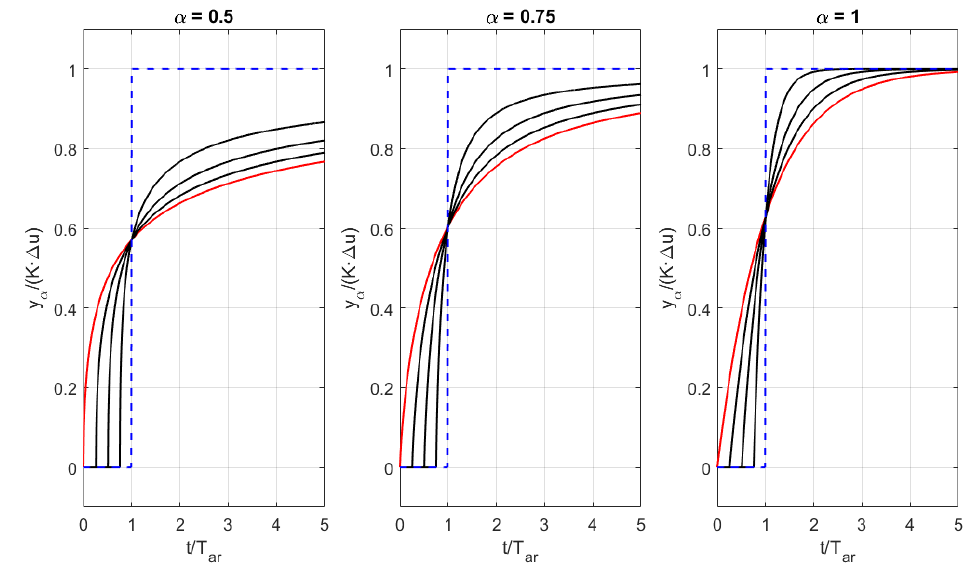
Figure 2. Normalized step responses y α /(K·Δu) vs. normalized time, where FFOPDT models for α = 0.5, 0.75, and 1.0 and τ = 0 (red), 0.25 , 0.5, 0.75, and 1 (blue) have been considered. Note that all step responses have a common point at t = T ar . Fractal Fract. 2022 , 6 , 526